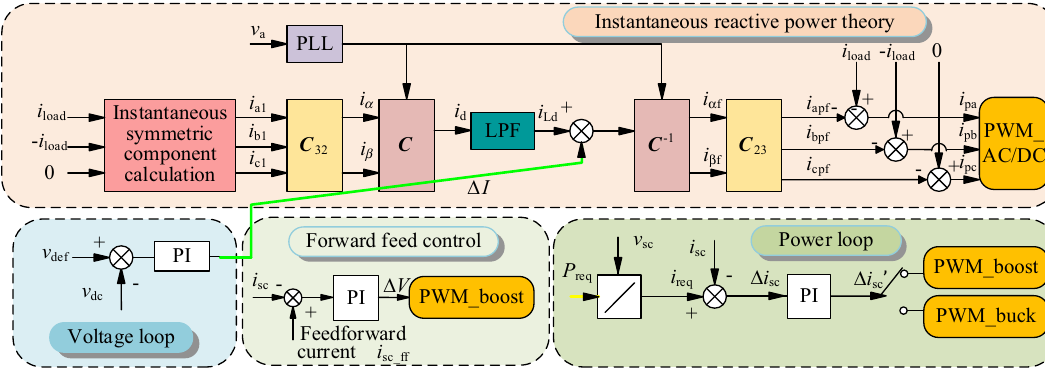
Fig. 9 General control scheme